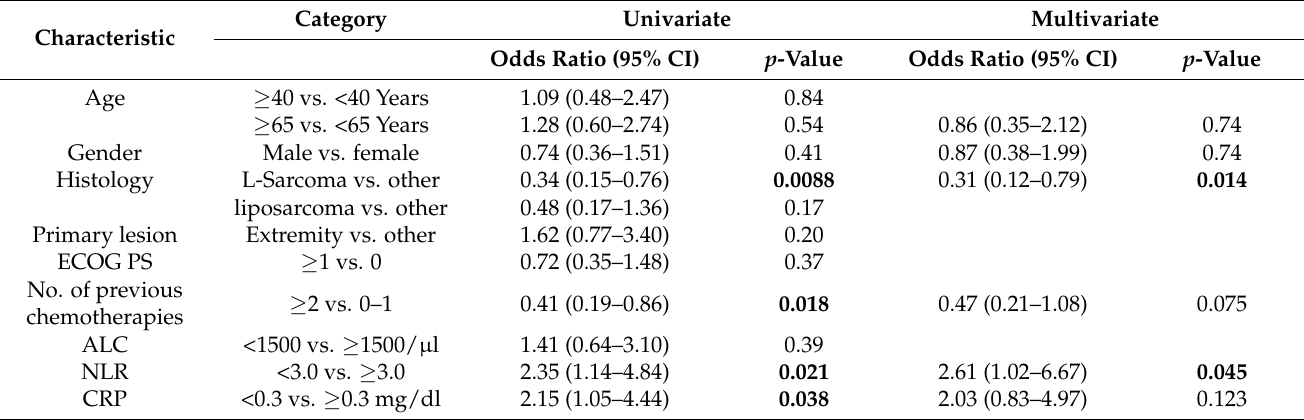
Table 3. Univariate and multivariate analyses of factors associated with durable clinical benefit.